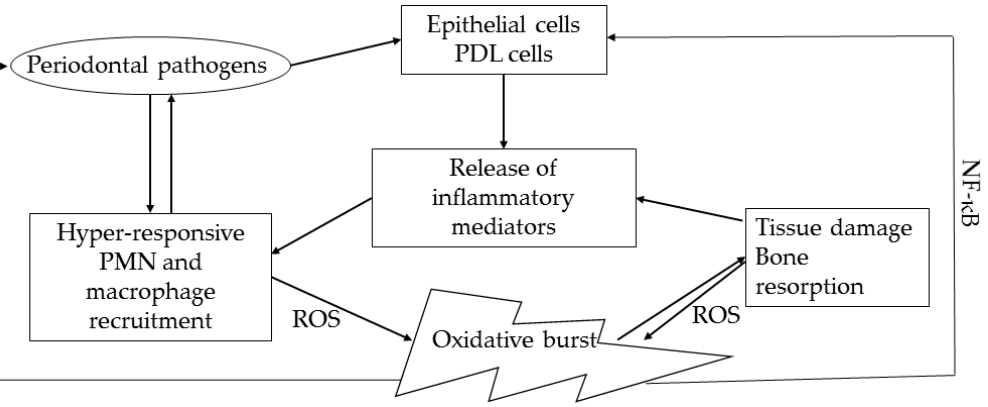
Figure 2. Oxidative stress in periodontal disease pathogenesis. PDL: Periodontal Ligament; ROS: Reactive Oxygen Species; NF- κB : Nuclear Factor kappa B.